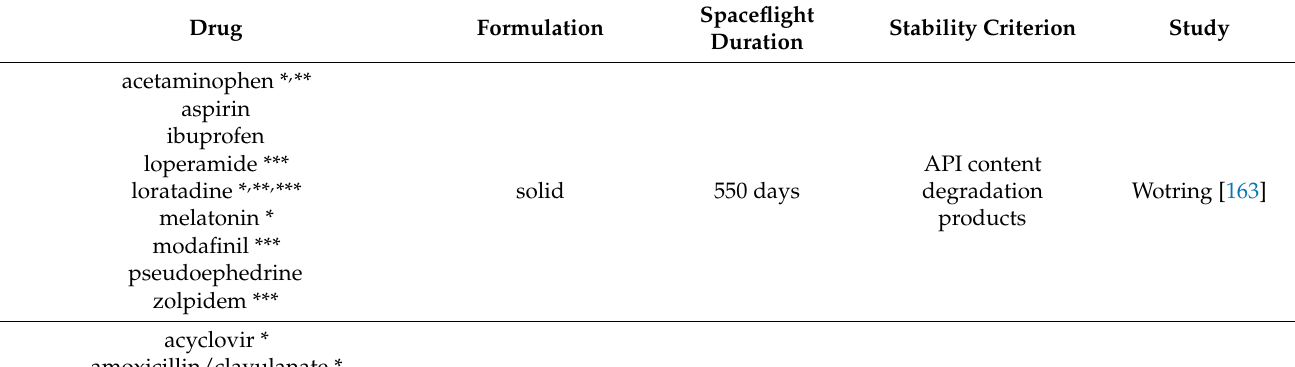
Table 1. Stability studies carried out on drugs subjected to the spaceflight environment. The majority of pharmaceutical agents were in solid formulations, a few semi-solid and liquid formulations being tested as well by Du et al. Space-flown pharmaceuticals have been compared to ground controls (excepting Wotring’s). A subset of terrestrial samples from Chuong et al. have also been exposed to heavy ion and proton